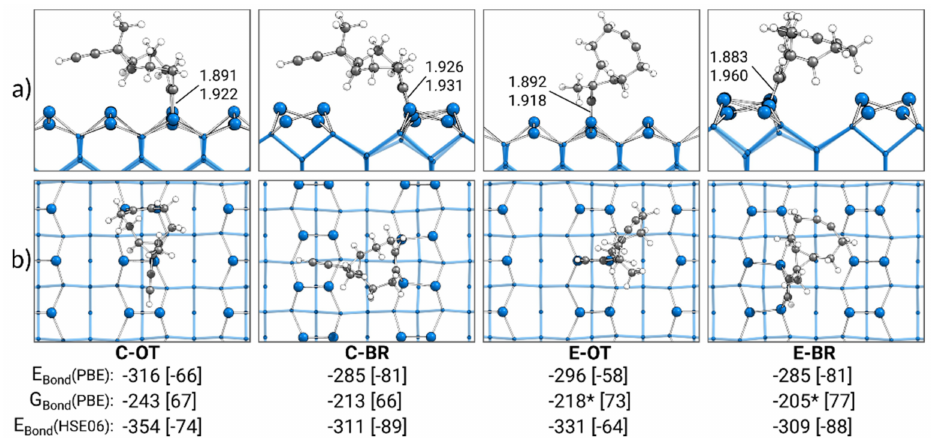
Figure 2. Singly bonded structures of ECCO on Si(001), with side ( a ) and top ( b ) views of the structures bonded by the cyclooctyne (C) or ethinyl (E) group in the on-top (OT) or bridge (BR) position. Electronic bonding energies (E Bond ) are shown with their dispersion contributions in brackets. Gibbs energies (G Bond ) are shown with their entropy contribution “ − T · ∆ S” at 300 K and 1 atm in brackets. An asterisk marks structures with small imaginary modes (see Section 2). All energies are expressed in kJ · mol − 1 . C-Si bond lengths are expressed in